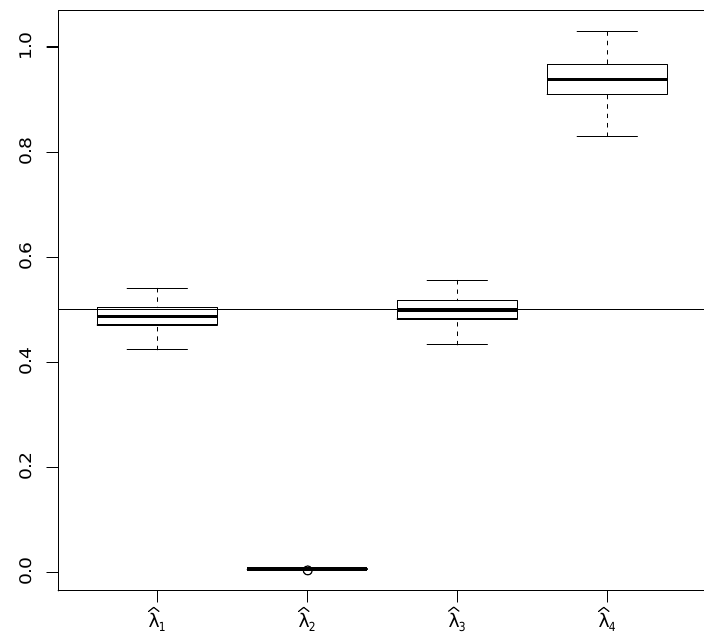
Figure 4. Comparison of (cid:98) λ 1 , (cid:98) λ 2 , (cid:98) λ 3 and (cid:98) λ 4 for 100 trajectories, where H = 0.6, x 0 = 100, T = 10, h = 0.1, σ = 2; the horizontal line shows the true value of the estimated parameter λ =